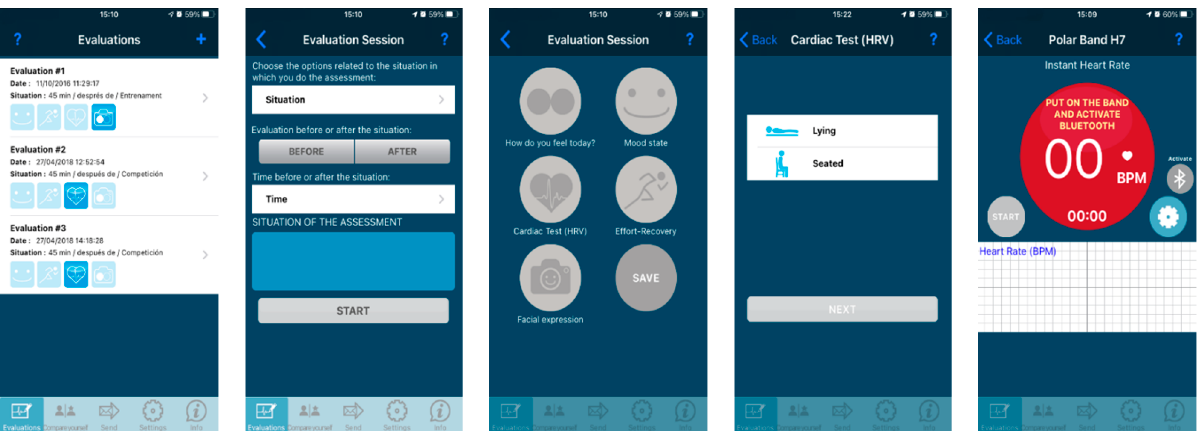
Figure 1. Screenshots sequence corresponding to the custom-made application (FitLab ® App). The first screen (left) shows all the stored recordings in the app pending to be synchronized with the server and the possibility to start a new one (“+” symbol). The next three screens ask for the situation where the recording takes place. The last screen (on the right) shows the instantaneous heart rate (in BPM) and the RR series.